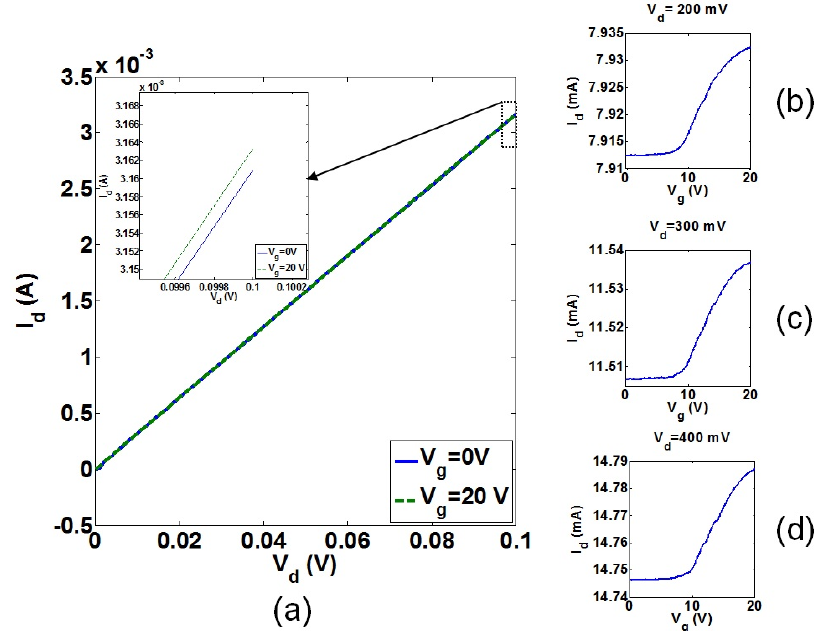
Figure 19. The N + /P/N + -type in-plane metal-oxide-semiconductor field-effect-transistor (MOSFET) with w = 135 nm, g = 80 nm and l = 2,000 nm: ( a ) the I V = 0 and 20 V and I g ( d ) V = 400 d